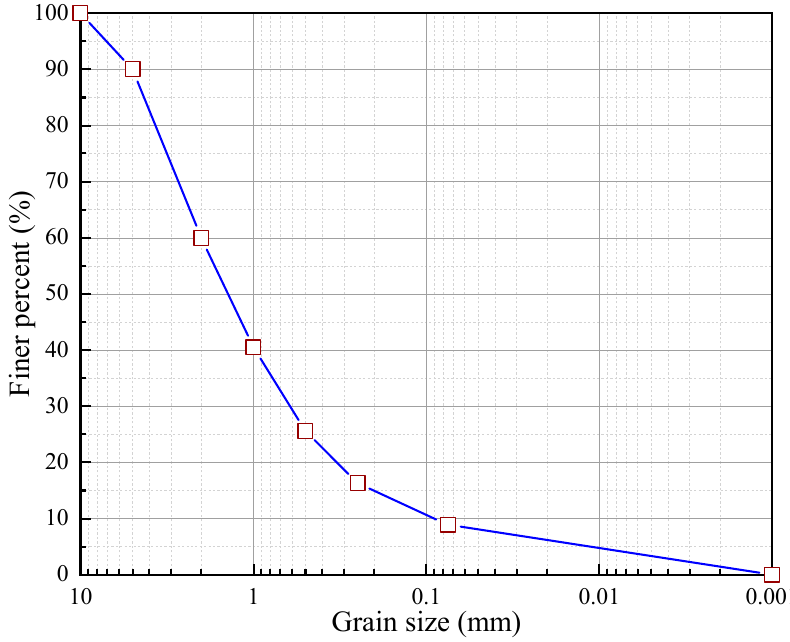
Figure 1. Gradation curve of the coral sand.